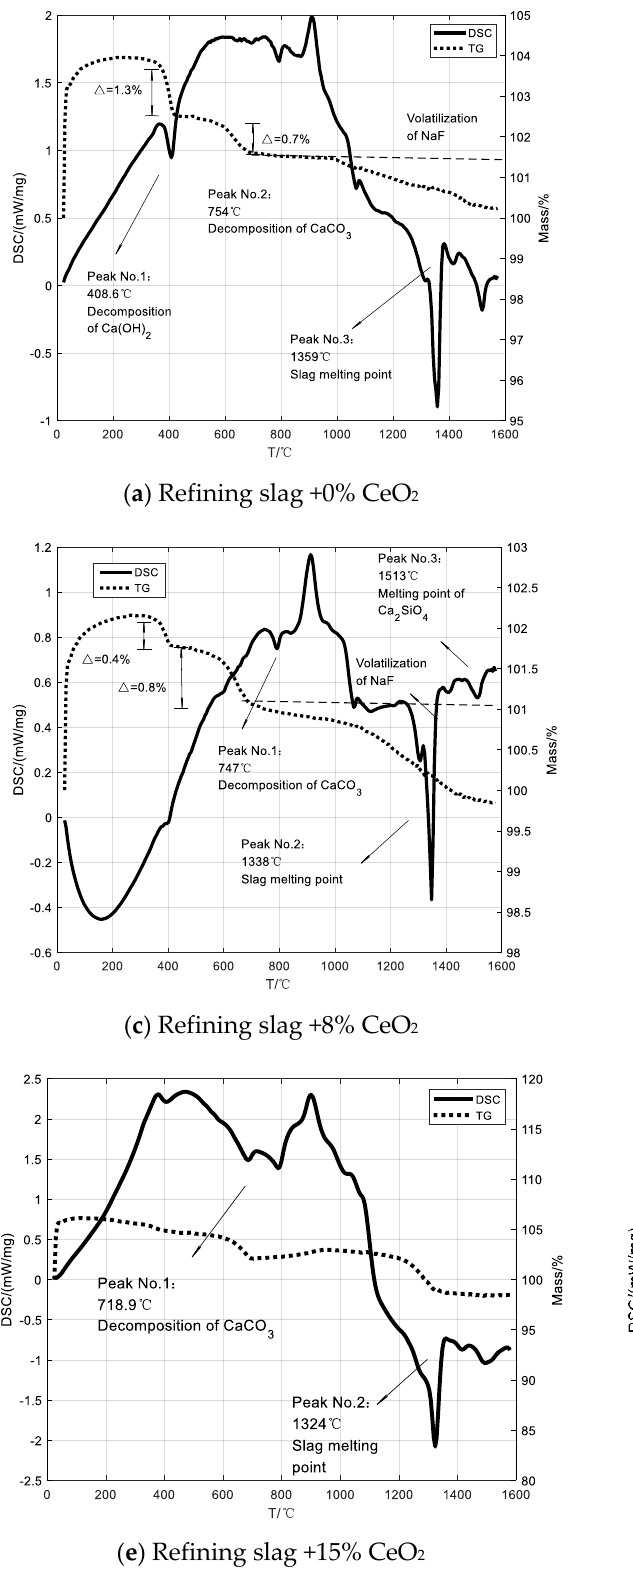
Figure 6. TG-DSC curves of slags. The endothermic peaks of CaCO 3 and Ca(OH) 2 appear in the DSC-TG curve because some of the powder after the preparation reacted with H 2 O and CO 2 in the air. During the